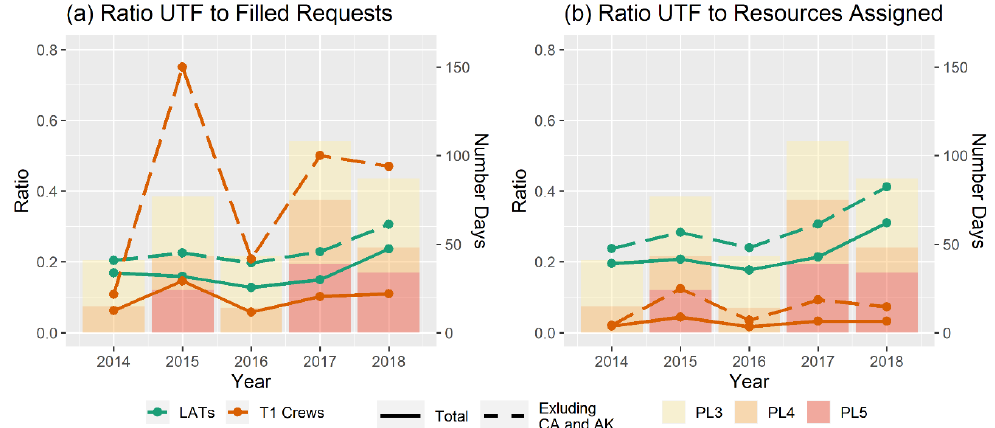
Figure 4. The ratio of large airtanker and type 1 crew of request returned Unable to Fill to Filled requests ( a ) and resources on assignment ( b ) in ROSS by calendar year against the number of days at or above Preparedness Level 3 for calendar years 2014–2018. The solid lines are all requests within the US. The dotted lines are for all requests except California and